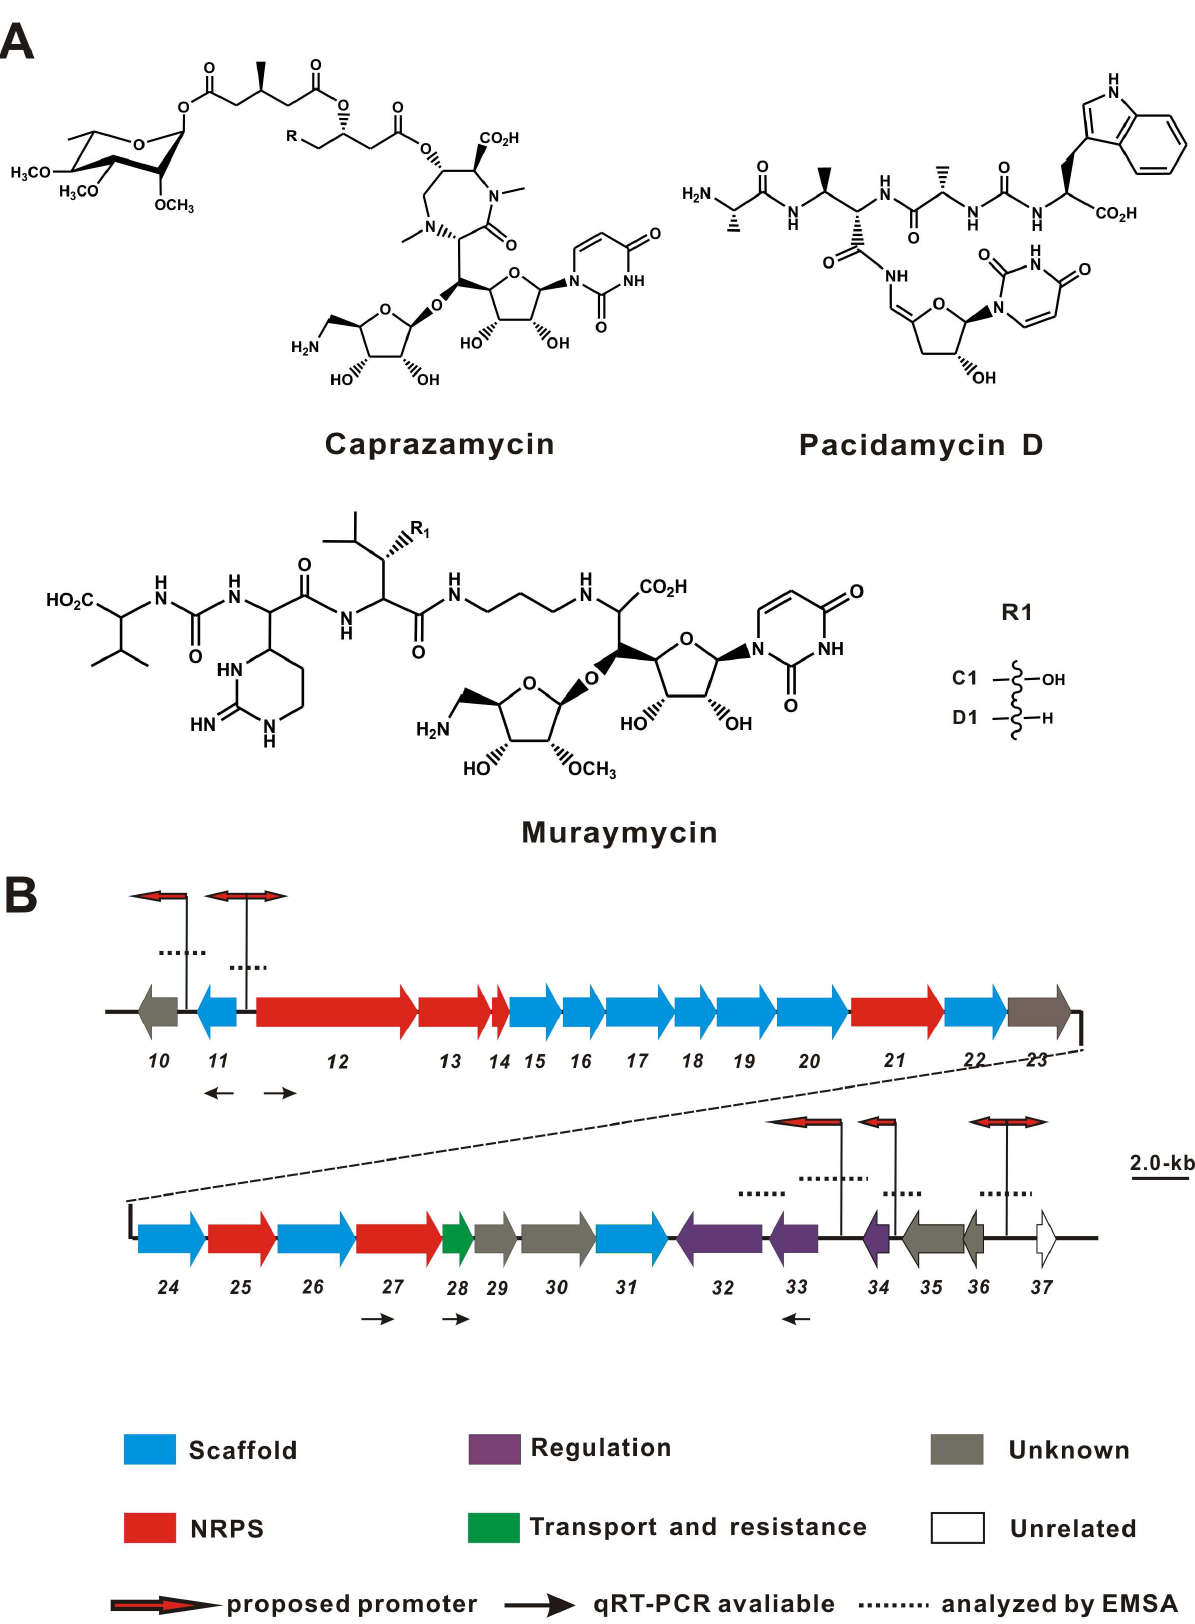
Figure 1. Chemical structure of related antibiotics (A) and genetic organization of the muraymycin gene cluster (B). Red arrows indicate the promoters which are probably the approximate binding sites of Mur34, black arrows mean the specific genes selected for quantitative